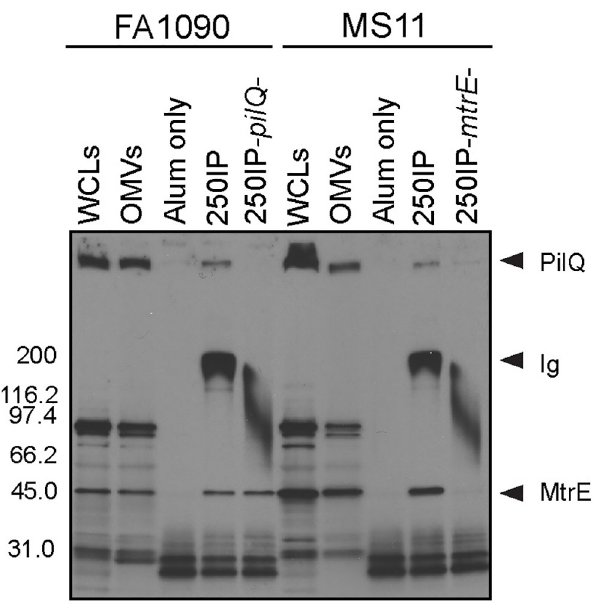
Fig 6. 4CMenB -induced antibodies bind PilQ and MtrE at the surface of viable Ng FA1090 and MS11 bacteria. Immunoprecipitations were performed with wild-type strains FA1090 and MS11 and their isogenic pilQ and mtrE mutants using antisera from mice immunized with 250 μ L of 4CMenB via the IP route (250IP) or given alum only (negative control). Bacterial components bound by 4CMenB-induced antisera were subjected to SDS-PAGE (non- denaturing conditions, 4–20% Tris-glycine) and Western blotting with 4CMenB 250IP antiserum. WCLs, total cellular proteins; OMVs, outer membrane vesicles; pilQ -, FA1090 Δ pilQ ; mtrE -, MS11 Δ mtrE . Data shown are representative of at least 2 separate experiments with identical results. The wide band around 200 kDa corresponds to the antibodies within the test antisera that are present in the antigen-antibody complexes and pulled down with the protein A/G